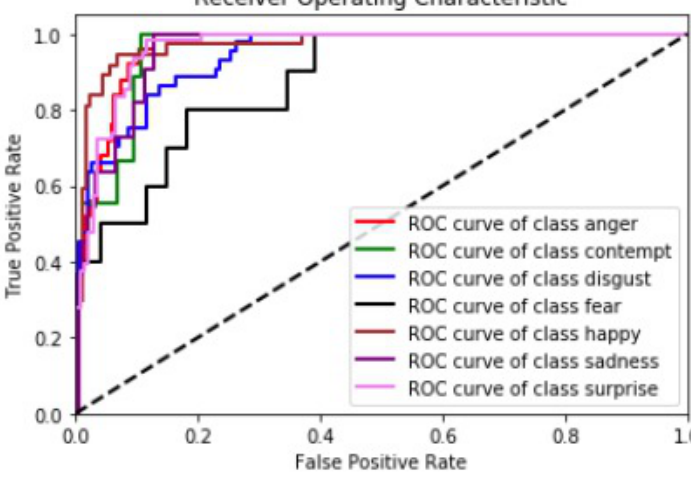
Figure 15. ROC of CK+ Dataset.